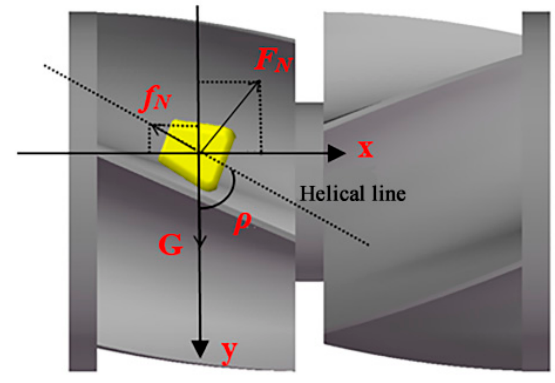
Figure 5. Sliding seed force analysis. A coordinate system with the x -axis and y -axis of vertical axis was established. The seed moves in space in the grooved wheel, and it is supported by the grooved wheel F N and by the maximum static friction force f N between the grooved wheel and the seed. Since the seed tends to move downward along the helix, the seed friction moves upward along the helix plane. The resultant force on the seed is decomposed into two forces in the x direction and y direction, which are F x and F y , respectively, as shown in Formula (3).